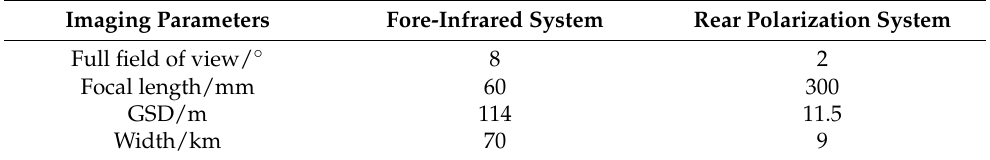
Table 1. Imaging parameters of the